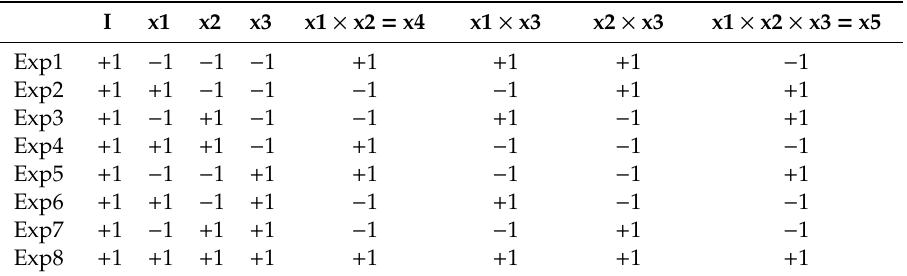
Table 4. Model matrix.